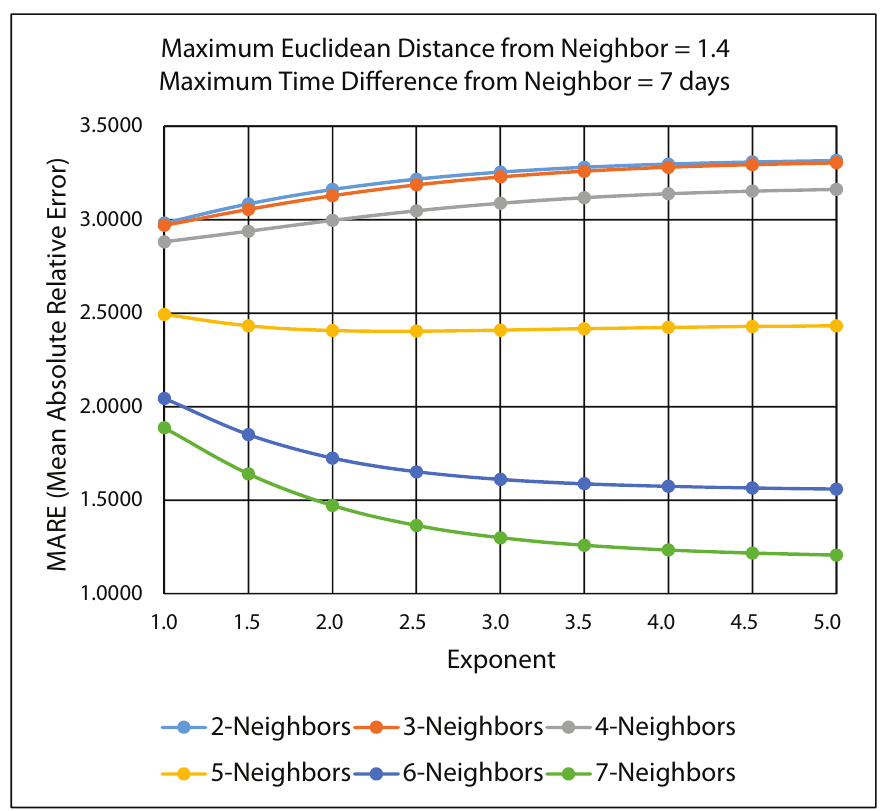
Figure 20. MARE 10-fold-cross validation results for the various 45 IDW methods using the improved IDW